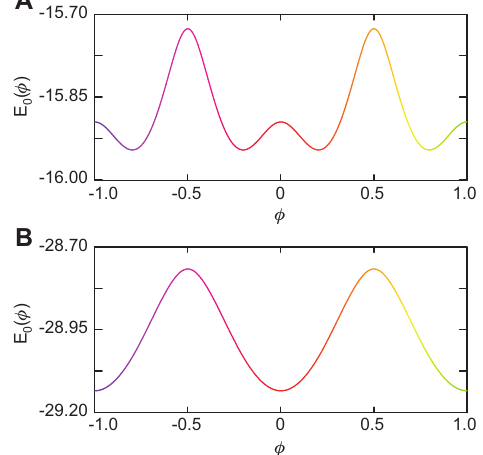
Figure 13 Ground state energy level as a function of fl ux φ for half-fi lled disordered mesoscopic cylinders ( M = 2) considering U = 1 and W = 2. (A) N = 5 and (B) N = 8.